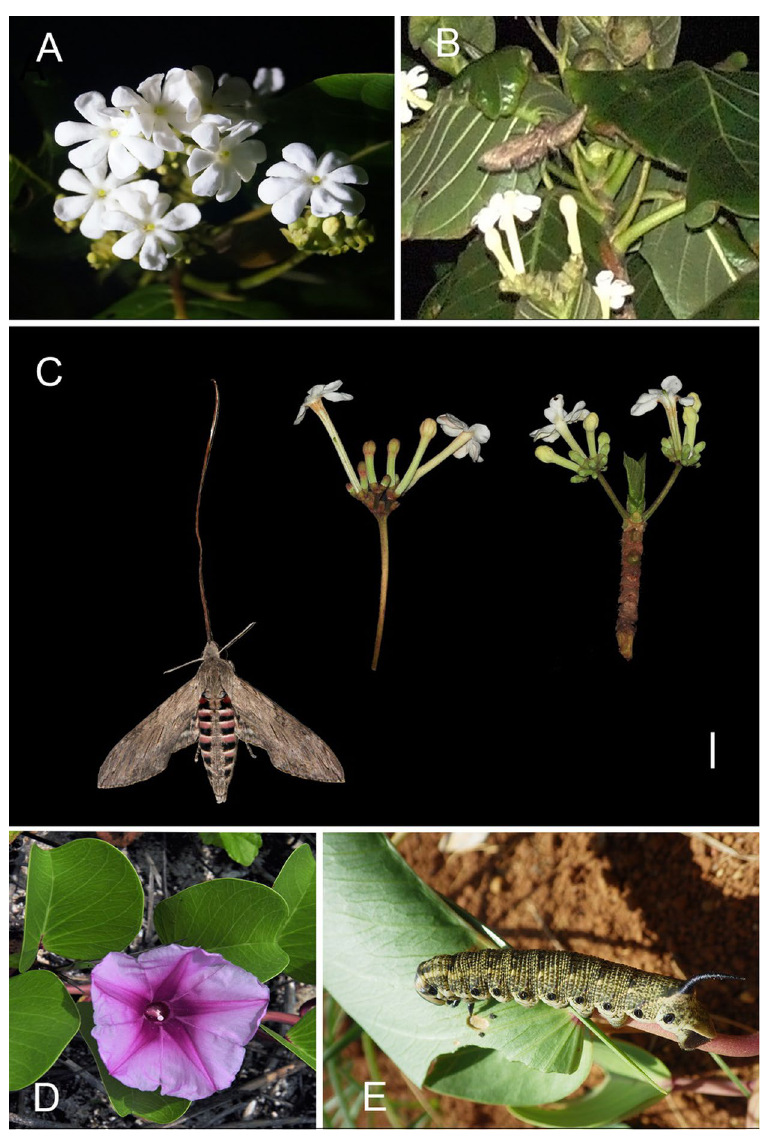
Figure 3. The flower and pollinator of Guettarda speciosa in study site. ( A ) Blooming inflorescence shows narrow corolla throat; ( B ) Agrius convolvuli is pollinating the flowers; ( C ) length comparison of the tongue of A . convolvuli and corolla tube of G . speciosa . Bar = 10 mm. ( D ) Ipomoea pes-caprae in natural habitat; ( E ) larva of A . convolvuli feeding on the leaves of I . pes-caprae , the host